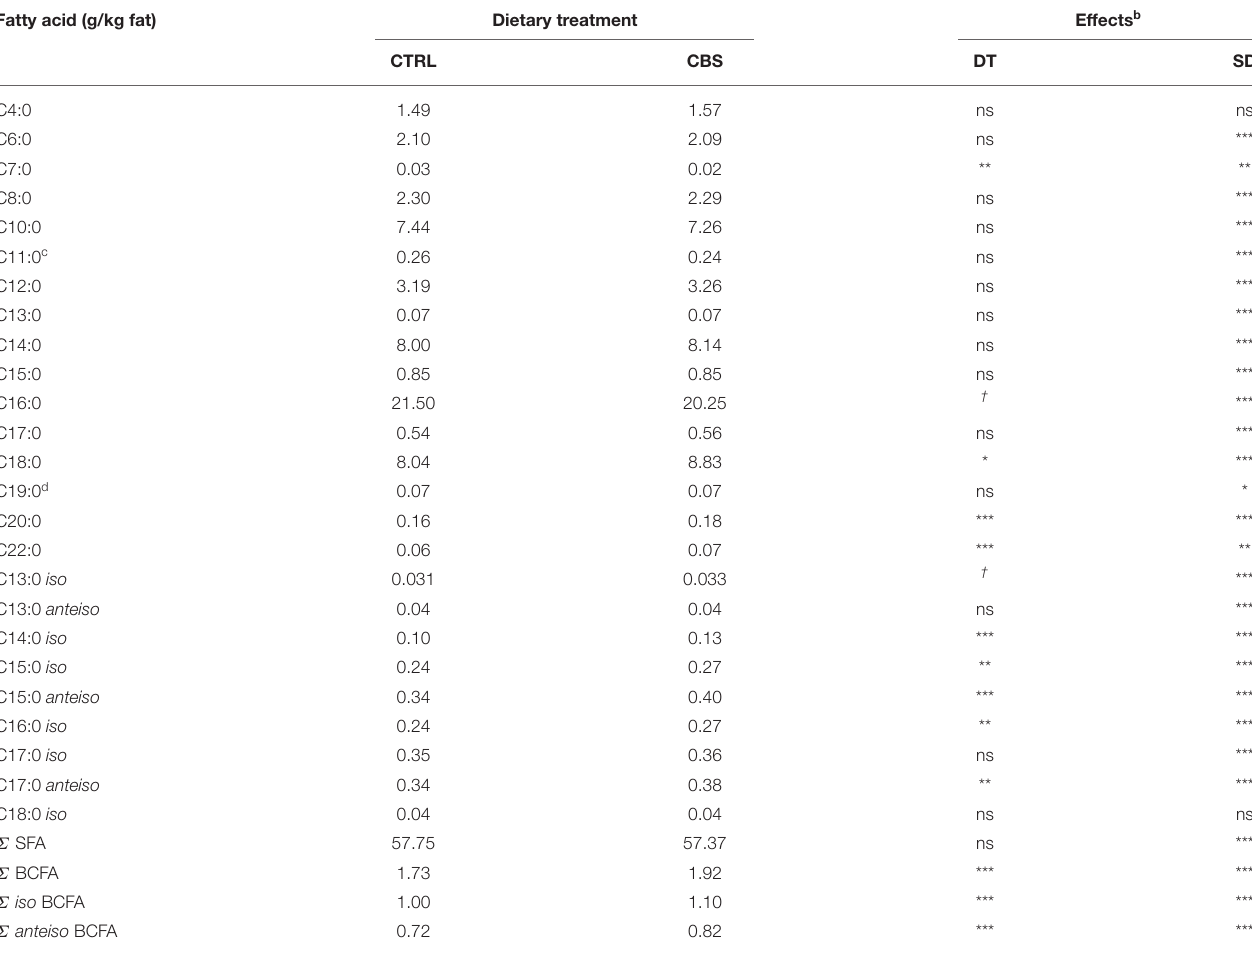
TABLE 4 | Saturated and branched-chain fatty acids (g/kg fat) in milk of goats fed the control (CTRL) and cocoa bean shell (CBS) diets a . Fatty acid (g/kg fat) Dietary treatment Effects b